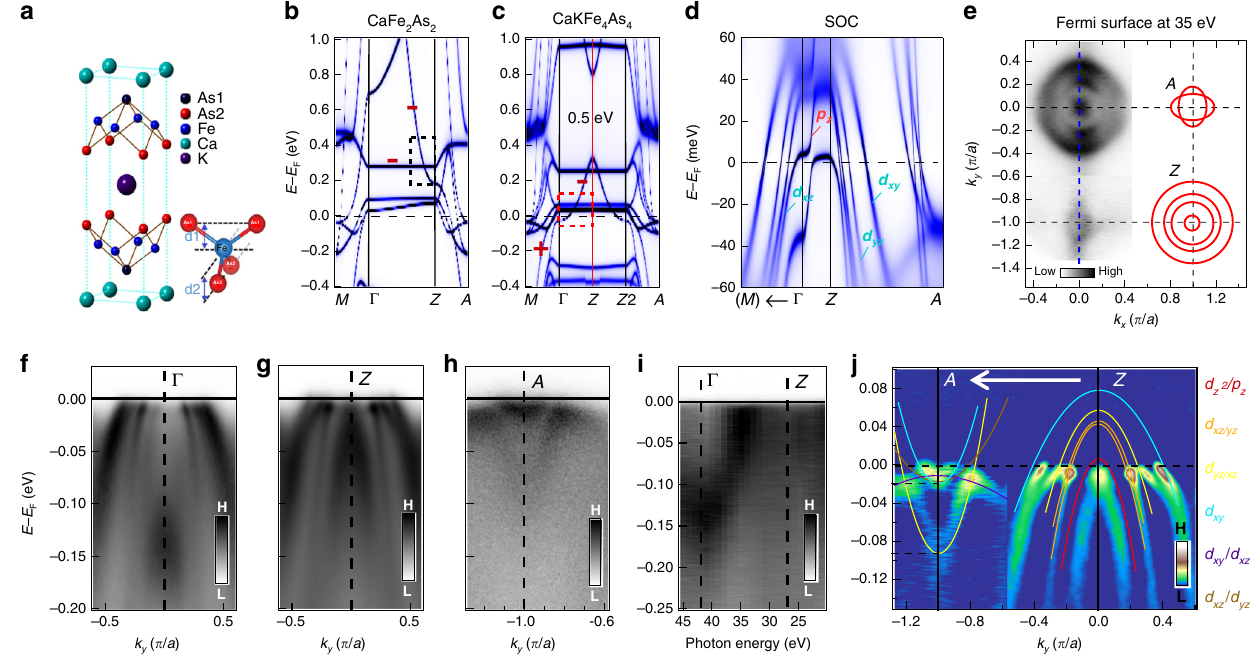
Fig. 1 Topological band inversion induced by bilayer structure in CaKFe 4 As 4 . a The crystal structure of CaKFe 4 As 4 with the inset of the As-Fe-As tetrahedron. The bond lengths ( d 1 , d 2 ) and angles are different between Fe-As 1 and Fe-As 2 15 . b – d DFT + DMFT calculation results for the band structures of b CaFe 2 As 2 , c CaKFe 4 As 4 , and d CaKFe 4 As 4 with SOC, respectively. In the b , c , the red symbols of “ + ” and “ − ” represent the band parity, and the red (black) dashed line box marks the position of the topological nontrivial (trivial) band inversion. The glide-mirror symmetry breaking effect in 1144 system is visible by comparing the band structures of CaFe 2 As 2 with CaKFe 4 As 4 . In CaKFe 4 As 4 , a large hybridization gap (~0.5 eV) is formed between the folded p z bands, and a band inversion with a SOC gap of 20 to 30 meV is found near E F at d . e Fermi surfaces measured by ARPES at a photon energy of 35 eV, which is around the middle point of Γ – Z , note that the ‘ a ’ in scale is 2.73 Å referring to the Fe – Fe distance of CaKFe 4 As 4 in the real space; the red contours on the right are extracted from DFT + DMFT calculation at Z and A , which shows good consistence with experimental Fermi surface. f – h ARPES spectral intensity plots along the blue dashed line in e with p -polarized photons at energies of 42 eV ( Γ ) and 27 eV ( Z and A ). i ARPES spectral intensity plot along the Γ – Z direction measured under photon energies from 21 to 45 eV. j The momentum distribution curve (MDC) second derivative of the ARPES intensity plot along the A – Z direction obtained from g , h , which enhances the vertical part of the band but suppresses the horizontal part of the band 32 , with comparison to the calculated results from d (plotted as colored